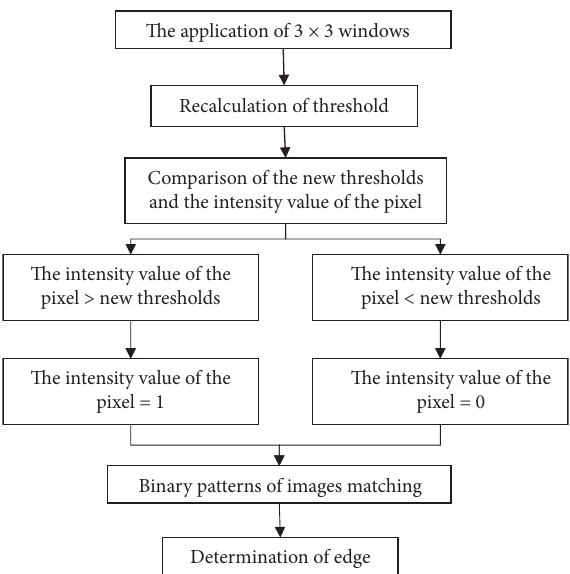
Figure 5: The schematic diagram of the algorithm.